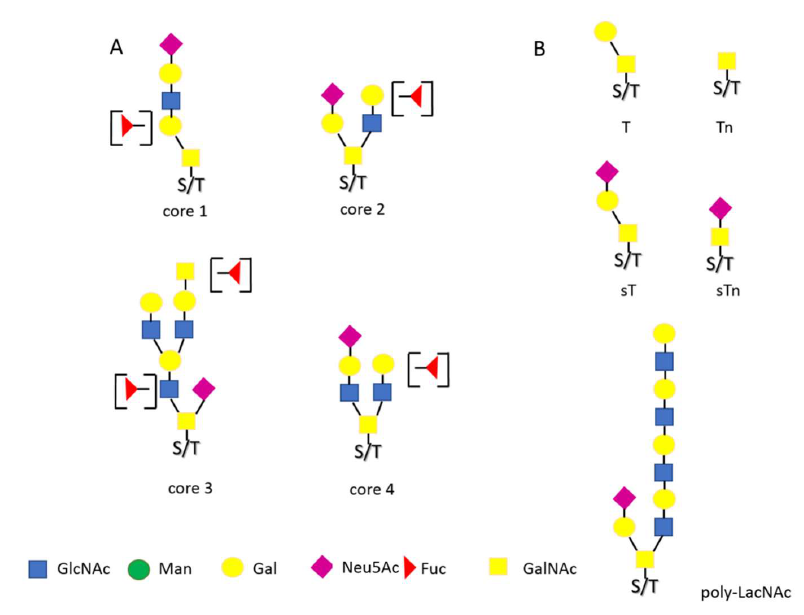
Figure 2. Examples of typical O-glycan structures; ( A ) dominant in healthy humans, ( B ) disease-